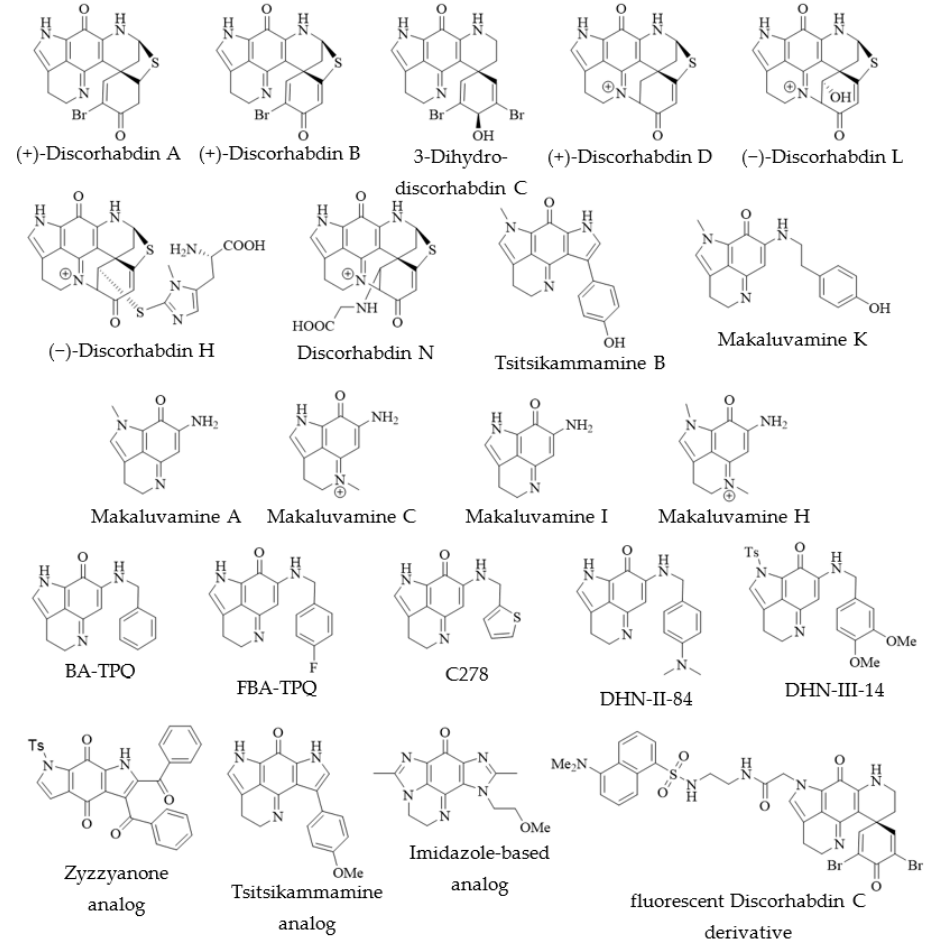
Figure 8. Selected natural and synthetic pyrroloiminoquinones with anticancer potential.